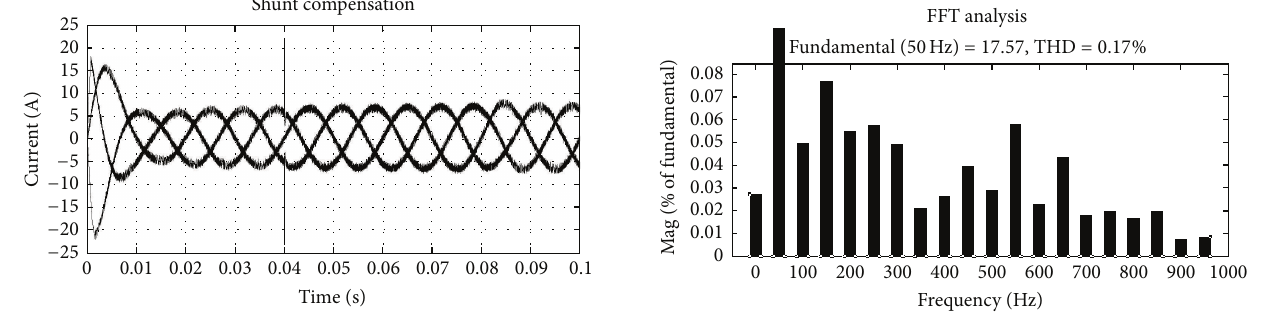
Figure 9: Shunt injection for THD compensation.